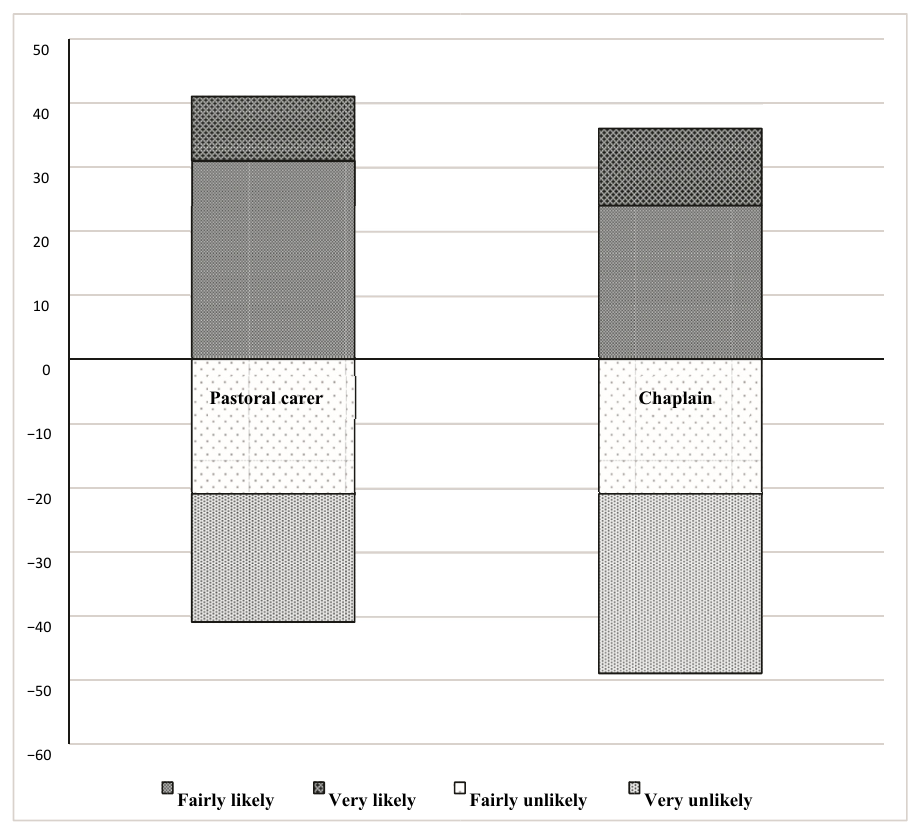
Figure 2. Likelihood of accessing care, all respondents.